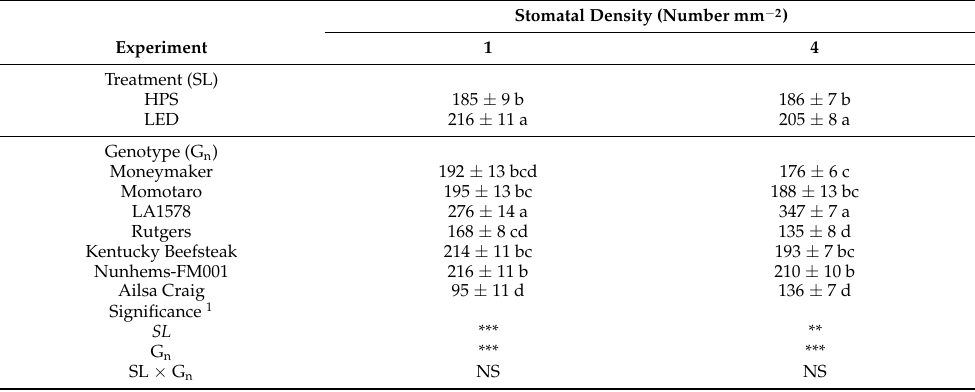
Table 2. Stomatal density ± SE (mm − 2 ) in seven tomato genotypes grown under HPS and LED supplemental light, in two experiments differing in fraction of SL over natural light (treatments: n = 21; genotypes: n = 3). Significance was tested by two-way ANOVA. Means followed by different letters within a column indicate significant differences according to Fisher’s protected LSD test ( p = 0.05 ). SL—supplemental light treatments; G n —genotypes ; SL—G n —interaction between SL and